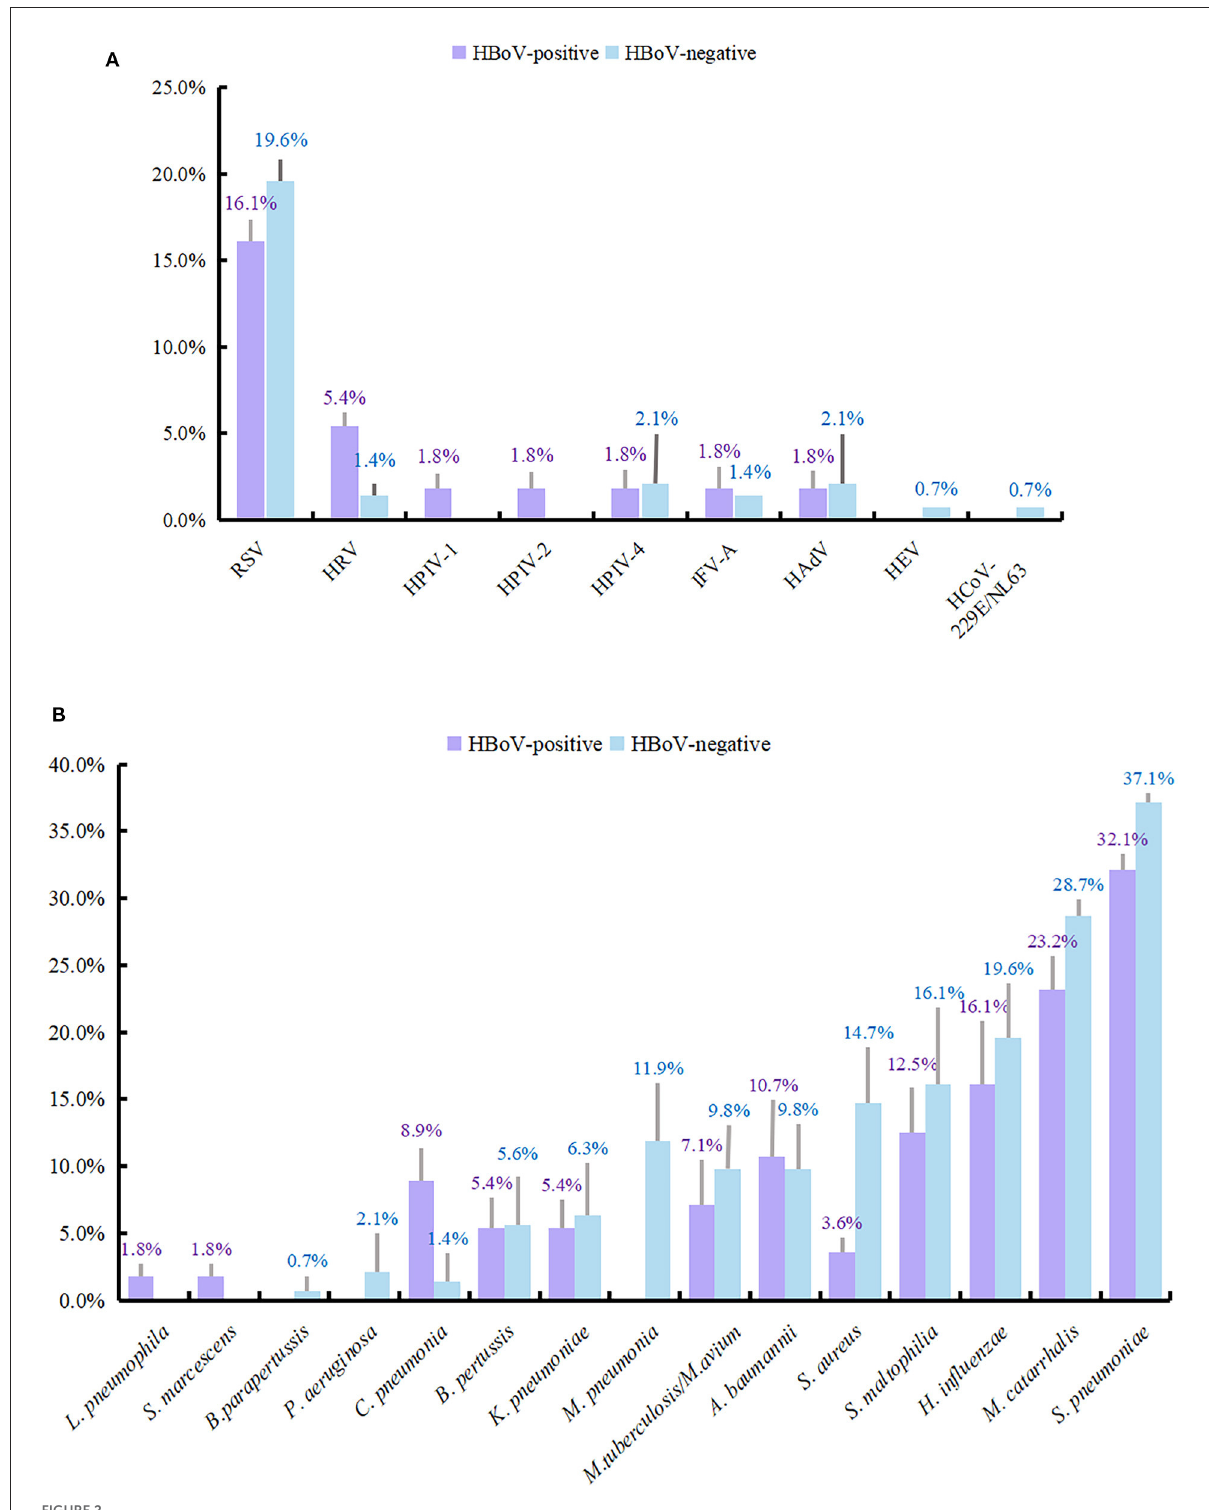
FIGURE2 Detection rate of viruses and bacteria in HBoV-infected group and uninfected group. The length of the color bar and the following number indicate the detection rate of each pathogen, with its positive number as the numerator and the number of people in each group as the denominator. (A) The detection rate of viruses. (B) The detection rate of